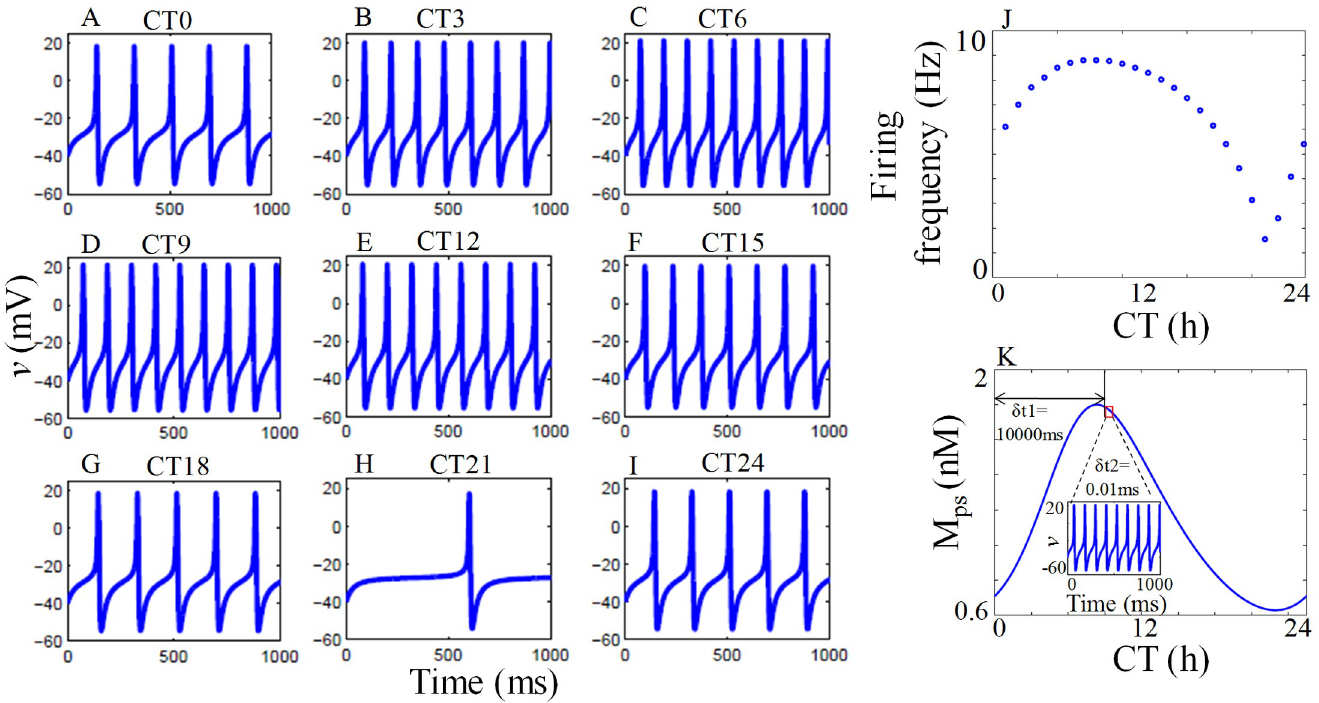
Fig 3. Circadian variation of firing frequency. (A-I) Time series of membrane voltage at different circadian phases. The number of spikes generated during the middle of subjective day (CT6) is higher in comparison to the middle of subjective night (CT18). A minimum number of spike is also observed during subjective night (CT21). (J) SFR as a function of circadian time. Firing rates show circadian variation that peaks during the day and reaches minimum value during the night, and this is in good agreement with the experimental results [5]. (K) Numerical simulation for SFR as described in the Algorithm-1. Here desired circadian time is CT9. From CT0 to CT9, the step size is 1000 ms , and at CT9, the step size is 0.01 ms for 1000 ms , and the corresponding firing patterns obtained is used to calculate the firing frequency at CT9.